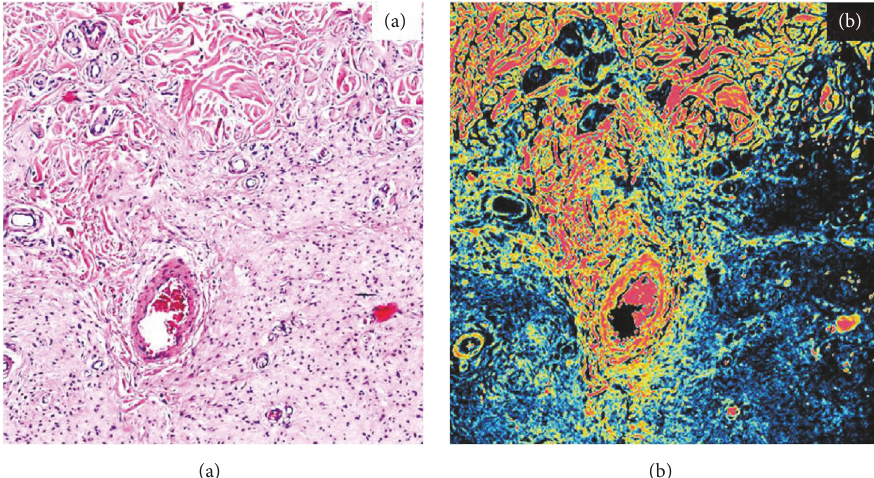
Figure 3: 50X. Traditional (a) and confocal laser scanning (b) analyses of an infiltrating plexiform neurofibroma with lack of fluorescence of proliferating Schwann cells in opposition with the high fluorescence of the fibroblasts of the deep